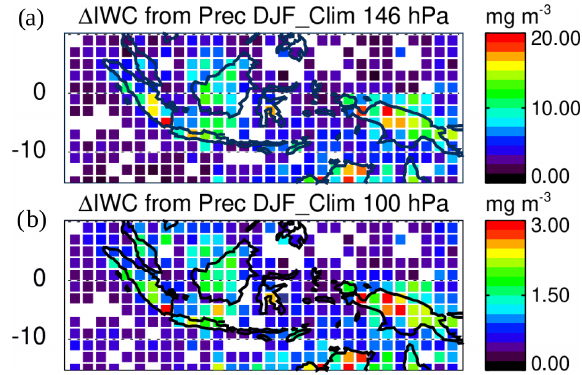
Figure 4. Daily amount of ice injected ( (cid:49) IWC) up to the UT (a) and up to the TL (b) estimated from Prec, averaged during DJF 2004–